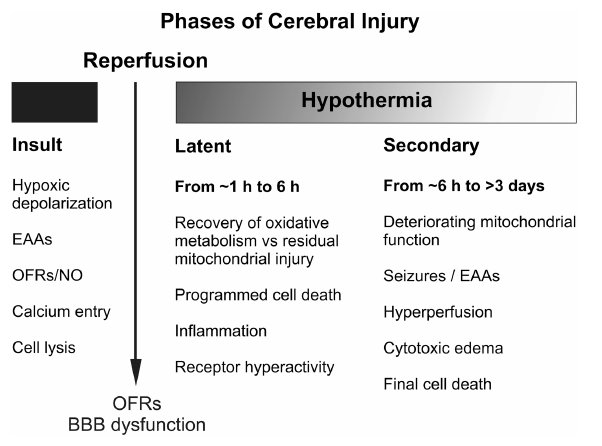
FIGURE 2 | Schematic diagram illustrating the different pathological phases of cerebral injury after severe hypoxic-ischemia. OFRs, oxygen free radicals; BBB, blood brain barrier; EAAs, excitatory amino acids; NO, nitric